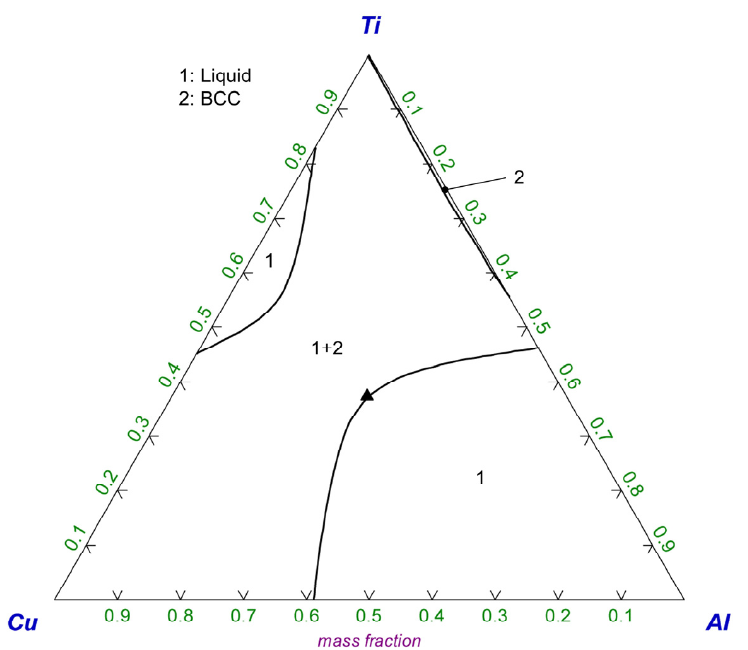
Figure 8. MP5 initial alloy (filled triangle) in Cu-Al-Ti-27% Cr pseudo ternary phase diagram for 1300 °C as calculated in FactSage 7.3 [33].